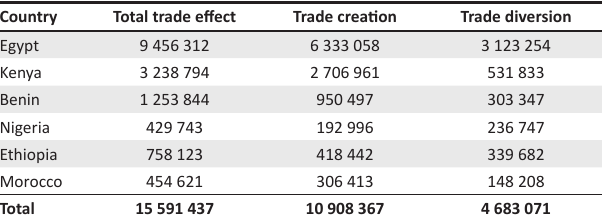
TABLE 2: Total trade creation in the South African market